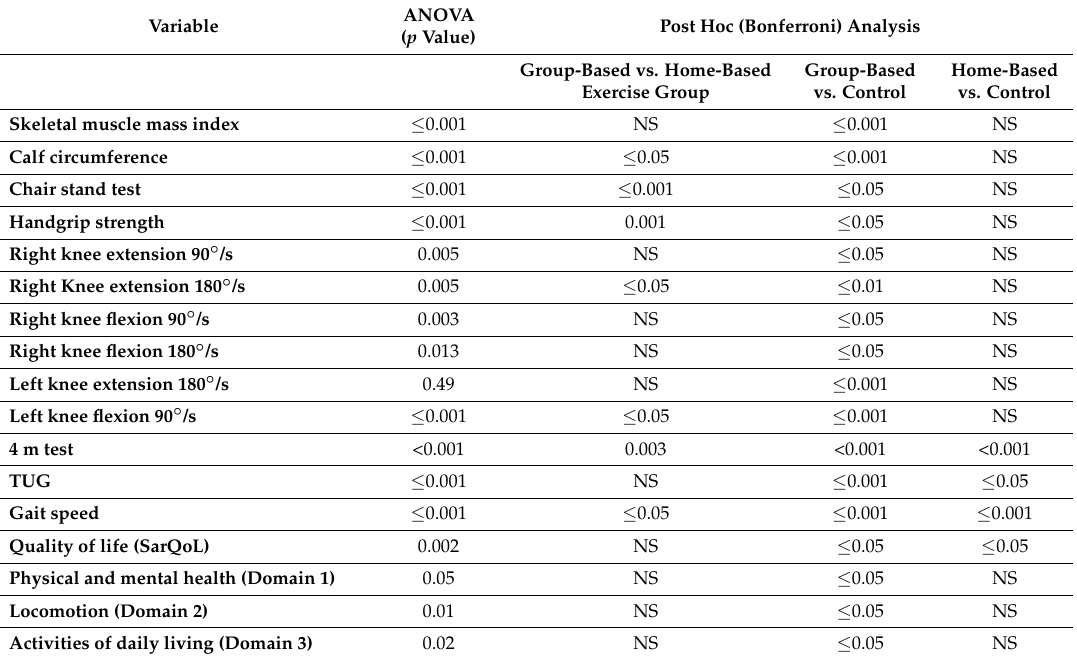
Table 6. Between-group comparisons at 24